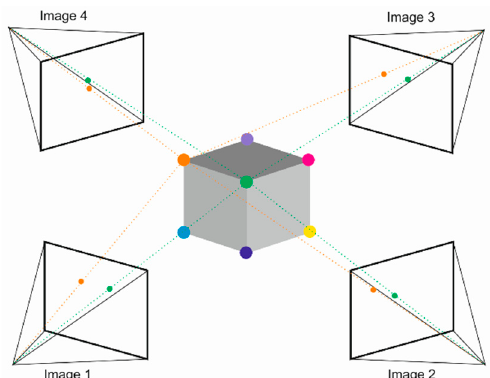
Figure 4. Operating principle of the SfM method—multiple images of the object captured from different angles.